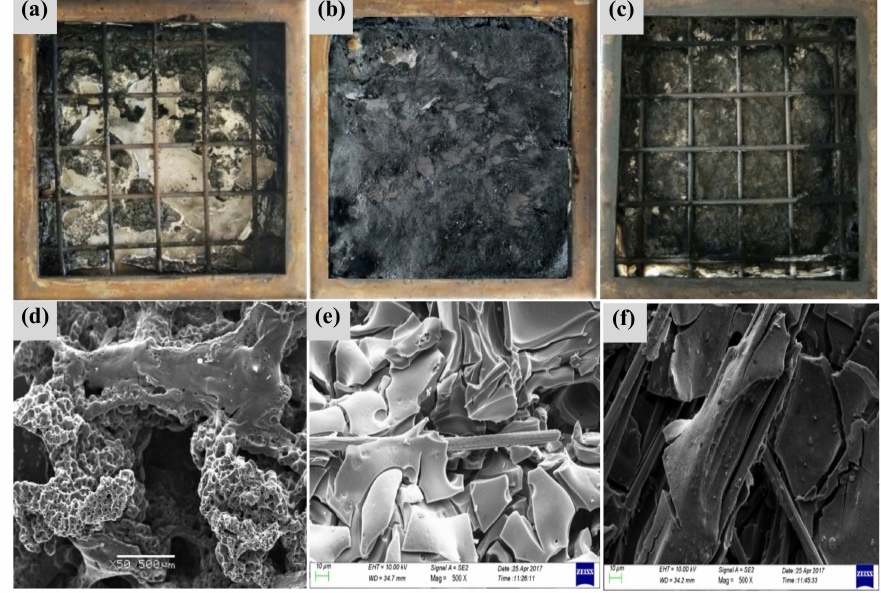
Figure 3. SEM of the combustion products. ( a ) Morphology of combustion products of EP ( b ) CF / EP and ( c ) CNTs / CF / EP. ( d ) Microstructure of residual carbon of EP, ( e ) CF / EP, and ( f ) CNTs / CF / EP composites